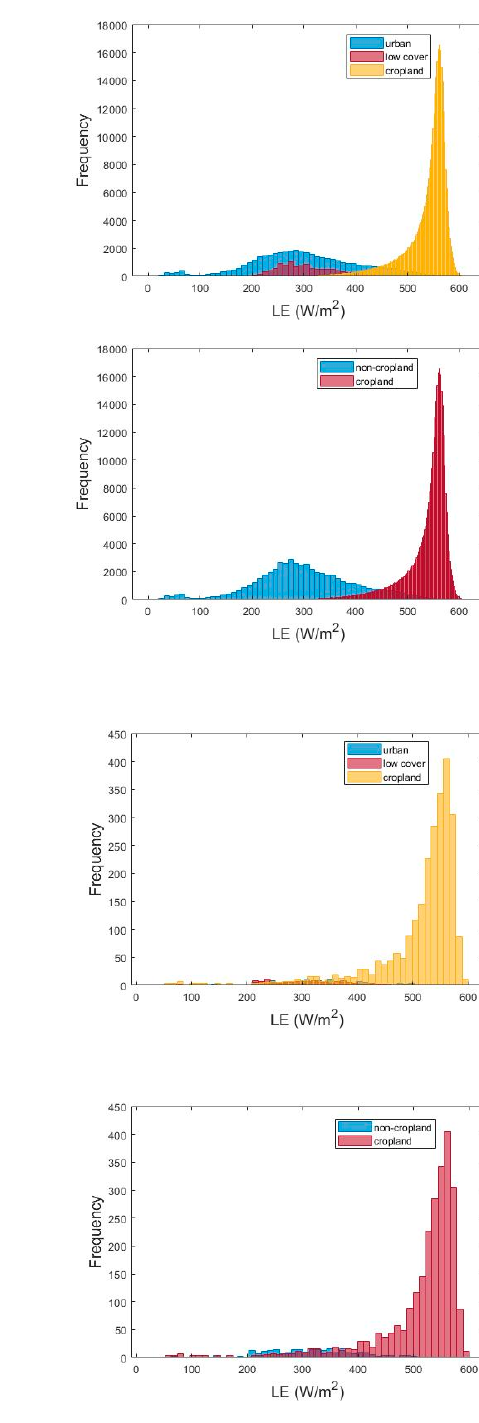
Figure 5. Comparison between ASTER derived ET (90 m, lower-left) and ET derived from aircraft image Track 9-2 (7.5 m, upper-left) maps and the associated histograms of the three main land cover types, alternatively combining urban and low canopy cover (semi-arid natural vegetation) under the broad land cover category of non-cropland.